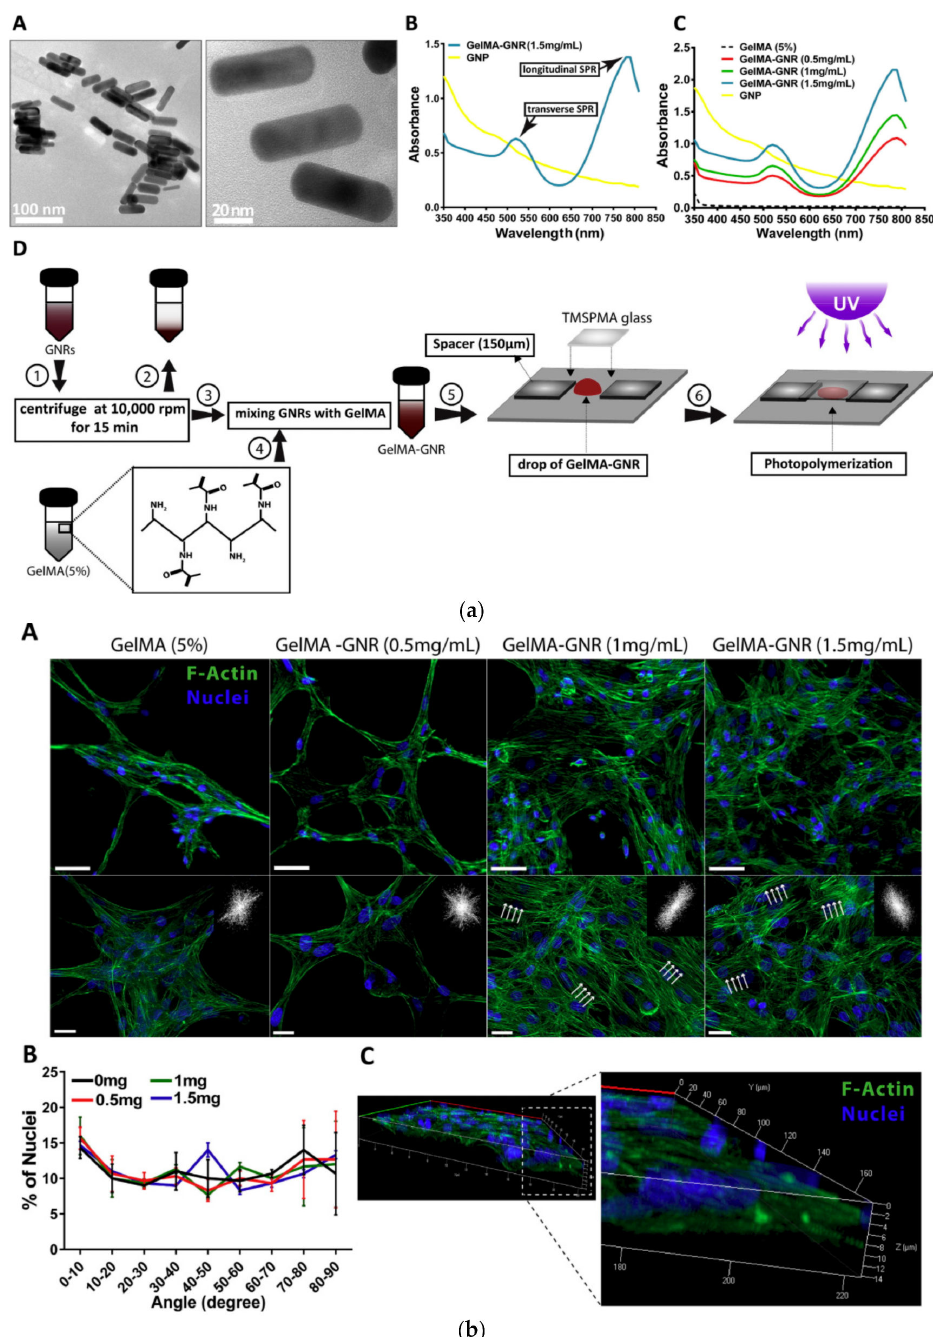
Figure 13. ( a ) Synthesis and characterization of GNR and GNR-GelMA hybrid hydrogels and ( b ) nuclei alignment and F-actin cytoskeleton organization of cardiomyocyte in GelMA only and GelMA-GNR hydrogels (reproduced from [163] with permission, copyright Elsevier,